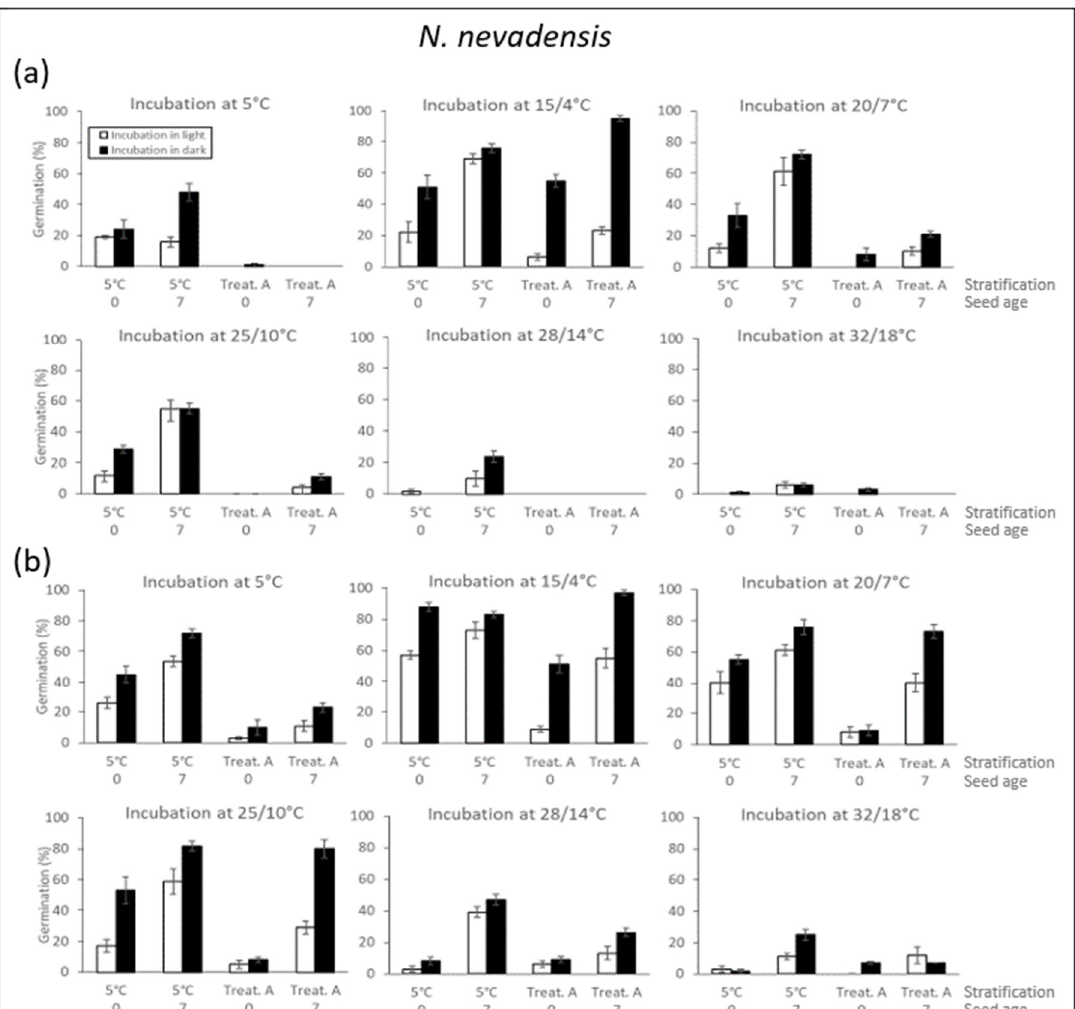
Figure 5. Germination percentages (mean ± standard error, standard error >2%) for N. nevadensis seeds at different incubation temperatures (5, 15/4, 20/7, 25/10, 28/14, and 32/18 °C) and ages (0 and 7 months) following different 120-day stratifications (5 °C and treatment A). ( a ) Stratification in light. ( b ) Stratification in darkness. White and black bars represent the germination percentages during incubation in light and darkness, respectively.